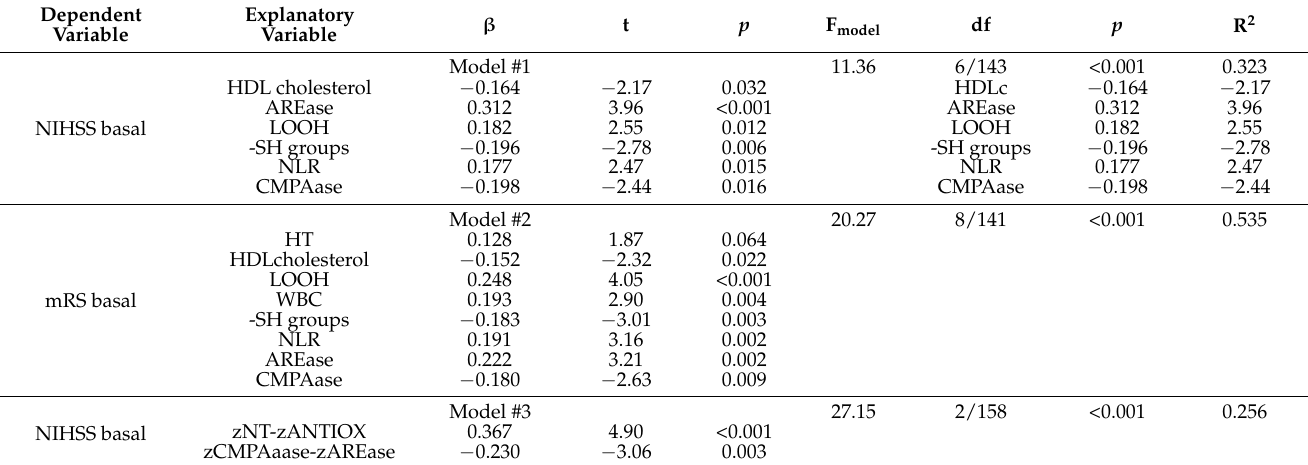
Table 5. Results of multiple regression analysis with the National Institutes of Health Stroke (NIHSS) ers as explanatory